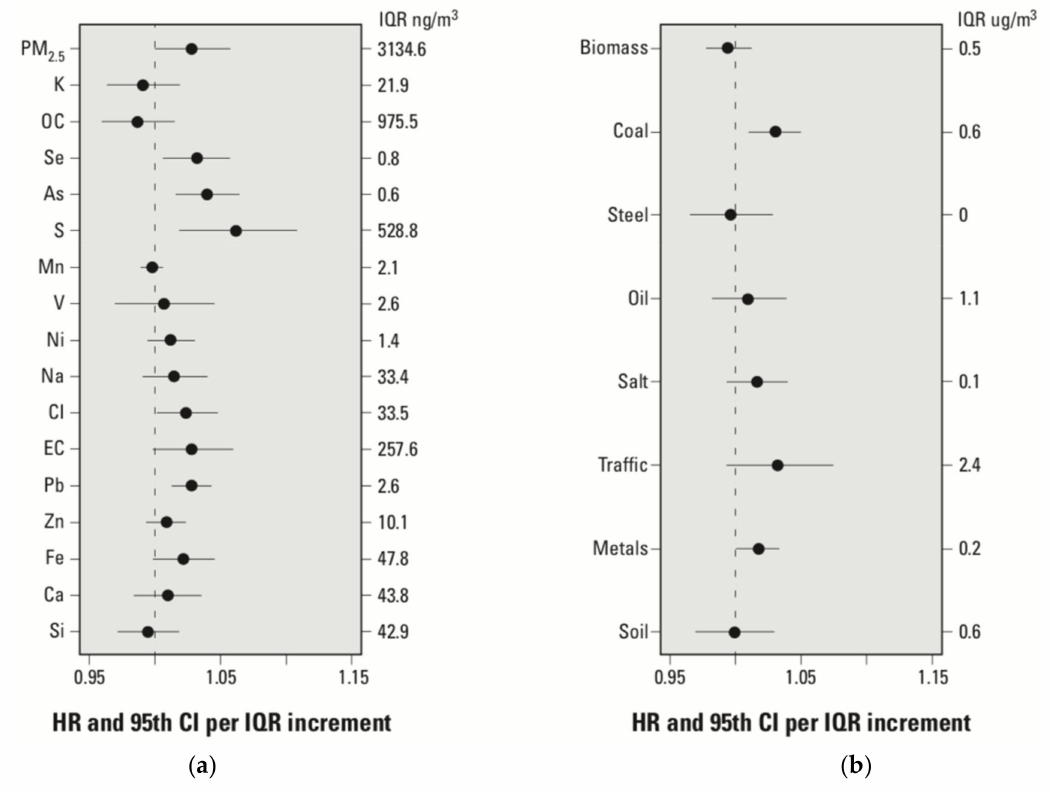
Figure 5. Cox random effects estimates of the ischemic disease mortality risks associated with ( a ) PM 2.5 elements and ( b ) source contributions, per interquartile range (IQR) in the US nationwide American Cancer Society cohort